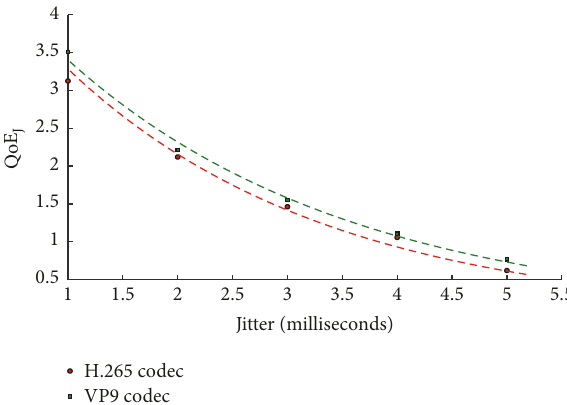
Figure 8: Relationship between jitter (ms) and QoE tive